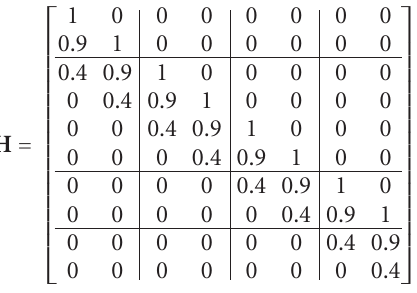
Figure 7: Structure of channel convolution matrix H for h ( n ) = { 1,0 . 9,0 . 4 } and block size of 8 samples. The received block is prolonged to 10 samples. For purpose of this paper, the matrix can be divided as indicated into 16 submatrices; H 11 in the upper left corner to H 44 in the bottom right corner. The division to submatrices is dictated by the CP size, here assuming 2, making the payload vector size 6.